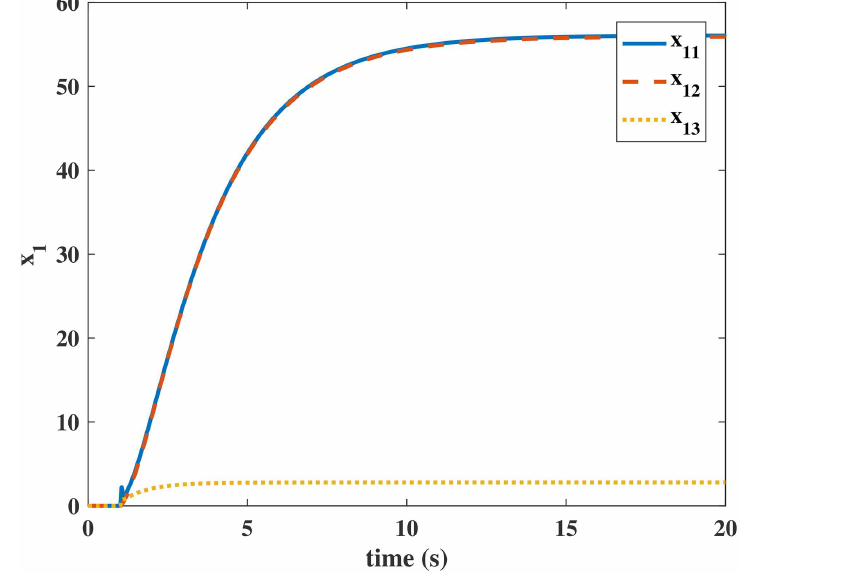
Fig 4. Response of x 1 in the numerical